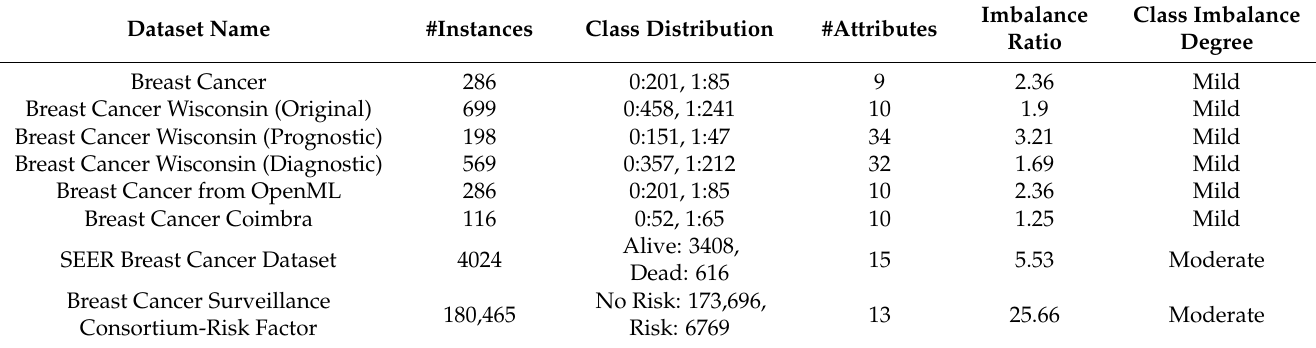
Figure 1. Illustration of class imbalance in breast cancer datasets. Table 2. Class-imbalanced characteristics in public open breast cancer datasets (clinical data).